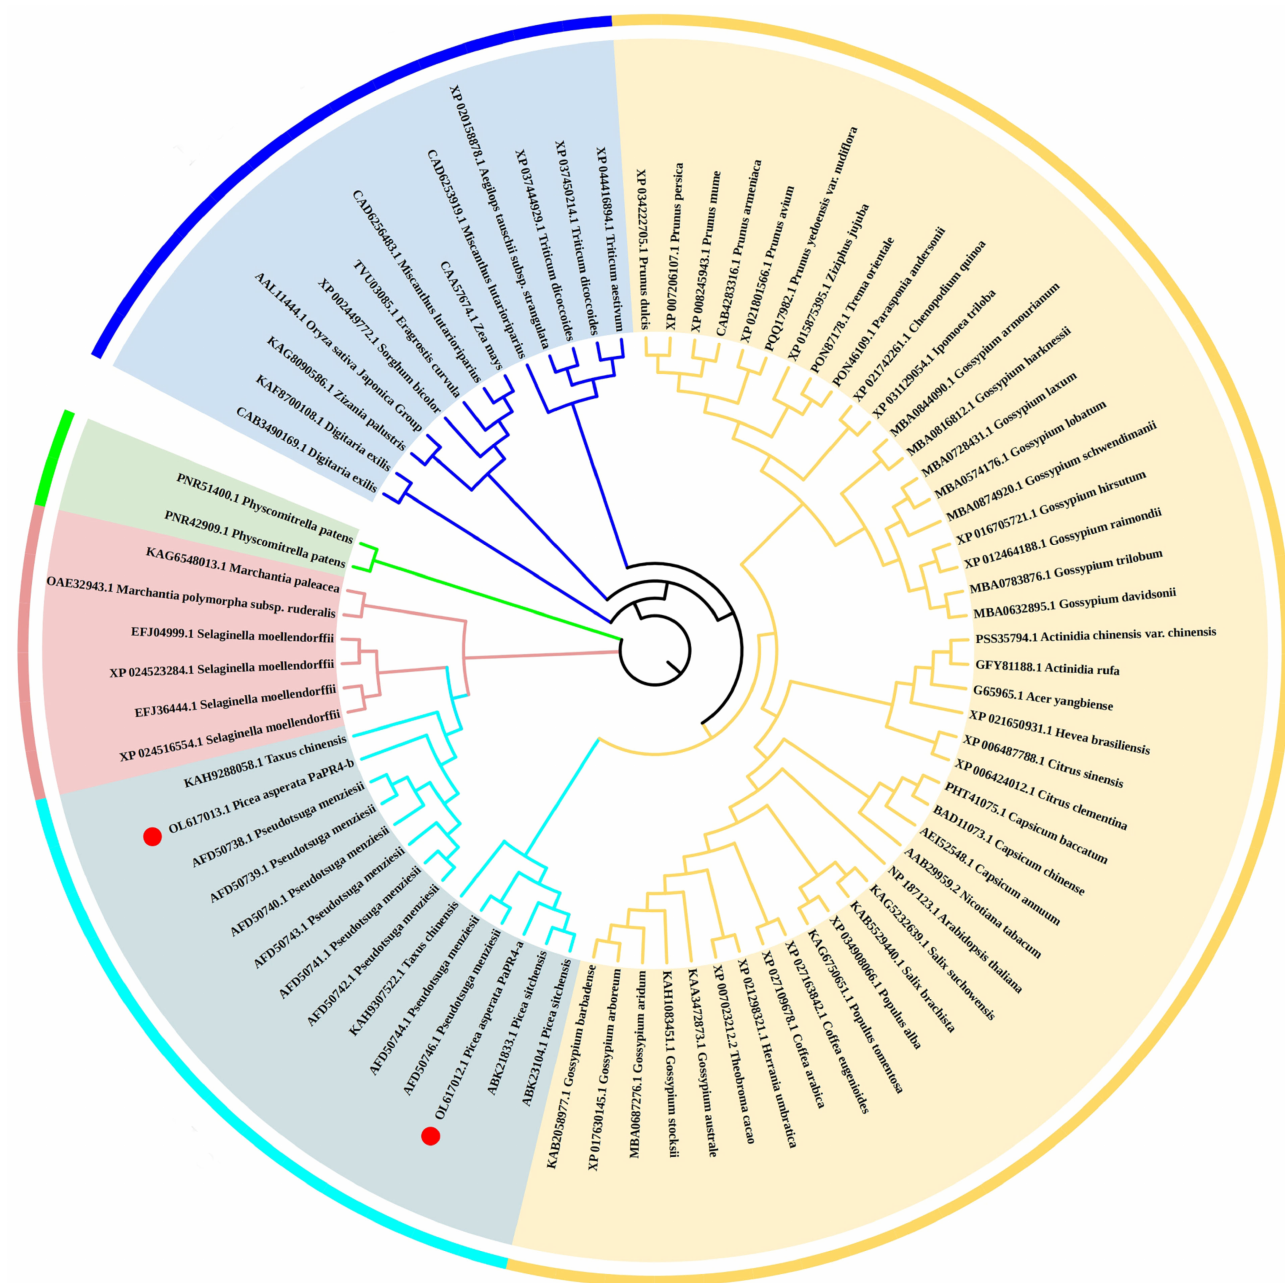
Figure 3. Phylogenetic tree of PR4 proteins constructed using the adjacency method. The monocotyle- dons, dicotyledons, gymnosperms, ferns and bryophytes are indicated in blue, yellow, cyan, pink and green, respectively. PaPR4-a and PaPR4-b are indicated as •